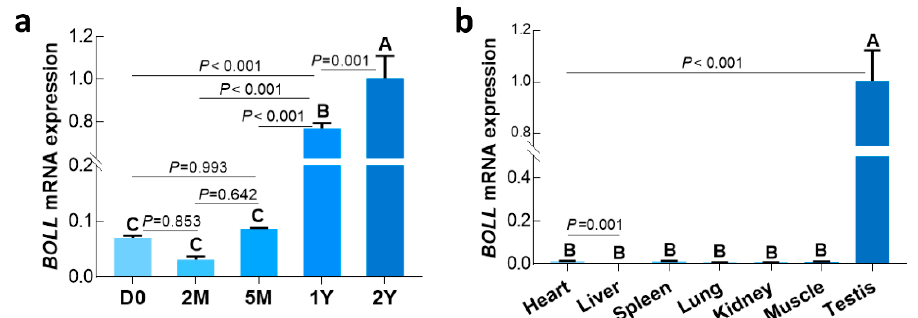
Figure 2. Relative expression of BOLL mRNA in selected sheep tissues detected by qPCR. ( a ) BOLL mRNA expression in sheep testis tissues at different development stages; ( b ) BOLL mRNA expression in testis and somatic tissues from 1Y sheep. β - actin was used as a reference gene. All experiments were biologically replicated three times, each with four technical replicates. The bars represent the mean values ± SD of 12 replicate samples obtained from three sheep per group. Different capital letters denote an extremely significant difference between groups ( p < 0.01). D0: 0 days old; 2M: 2 months old; 5M: 5 months old; 1Y: 1 year old; 2Y: 2 years old.